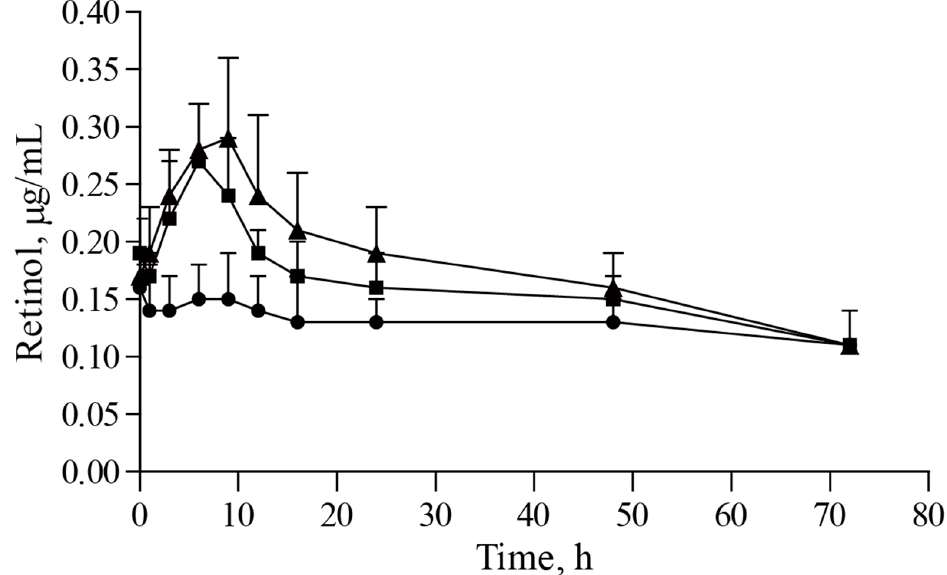
Figure 1. The plasma concentration of retinol versus time. The concentration of retinol in plasma from 0 to 72 h after oral placebo ( ● ), non-microencapsulated vitamin supplement ( ▪ ), and microen- capsulated vitamin supplement ( ▲ ), respectively. Error bars represent standard deviations.